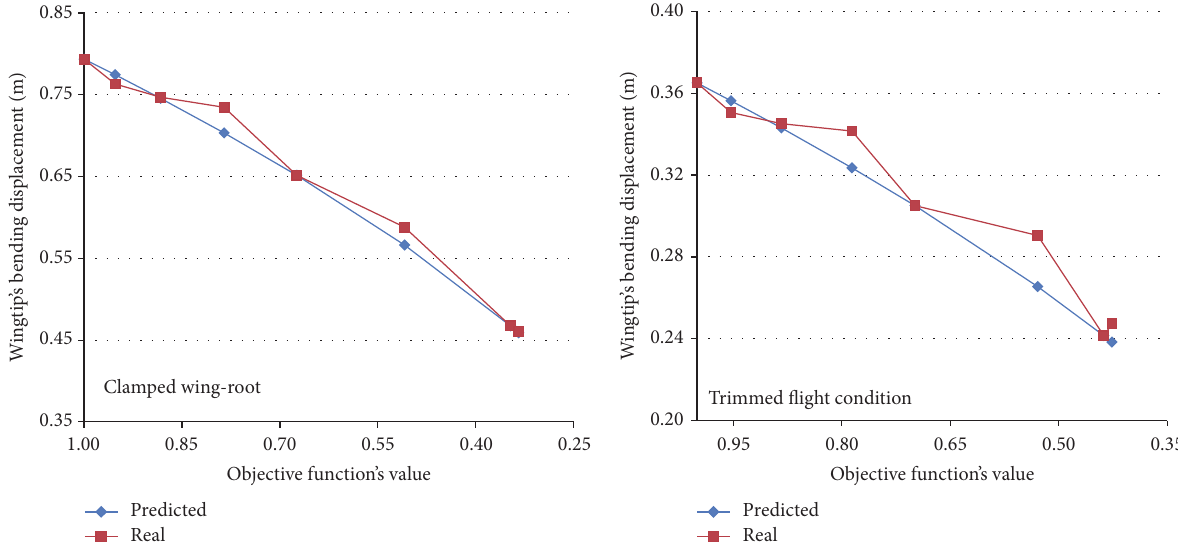
Figure 10: Predicted and real result for the cases with and without the aircraft rigid-body mode.